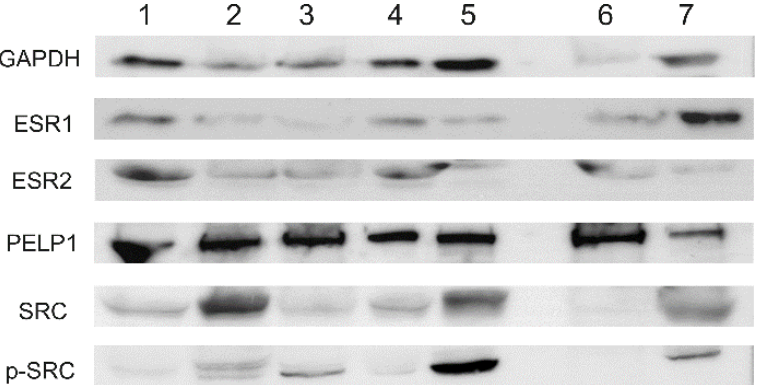
Figure 5. Western blot analysis in selected cases of ovarian cancer tissues (1–5) and noncancerous ovary (6–7).